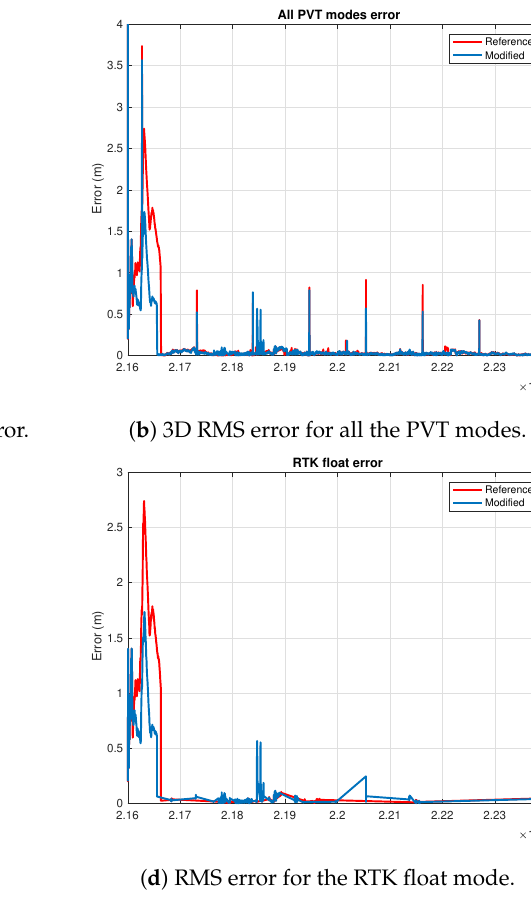
Figure 14. Graphical results of the PVT error when applying (blue curves) or not (red curves) 2pol exclusion in the urban environment.